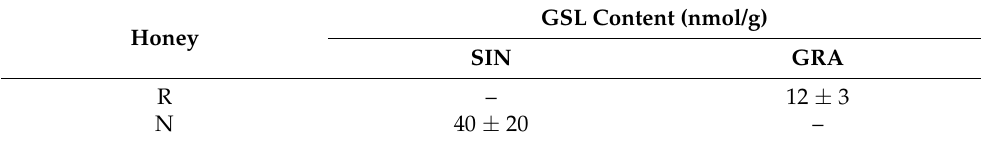
Table 4. Glucosinolate (GSL) content of honey produced by the bees fed on R and N for 28 days. GSL content is expressed as nmol/g of honey. Mean values ± standard deviation ( n = 5) are shown. GSL Content (nmol/g) Honey SIN GRA R – N 40 ± 20